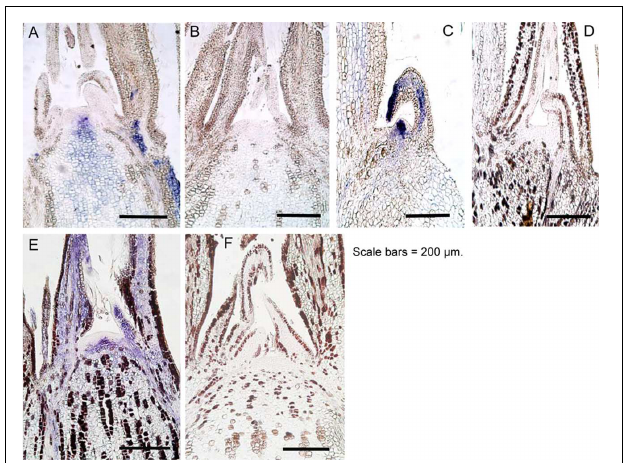
FIGURE 6 | In situ hybridization of shoot apical meristem and lateral buds of apple and pear seedlings infected with ALSV. (A) and (C) , apple seedlings grown at 25 ◦ C. (B) and (D) , apple seedlings grown at 37 ◦ C for 4 weeks followed by 25 ◦ C for 4 months. (E) Pear seedling grown at 25 ◦ C. (F) Pear seedling grown at 37 ◦ C for 4 weeks followed by 25 ◦ C for 4 months.